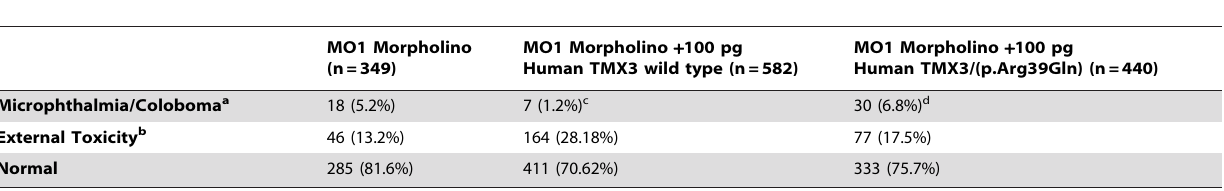
Table 2. Frequency of Microphthalmia and/or Coloboma with 6 ng MO1 Morpholino and 100 pg human TMX3 wild type or 100 pg of human TMX3